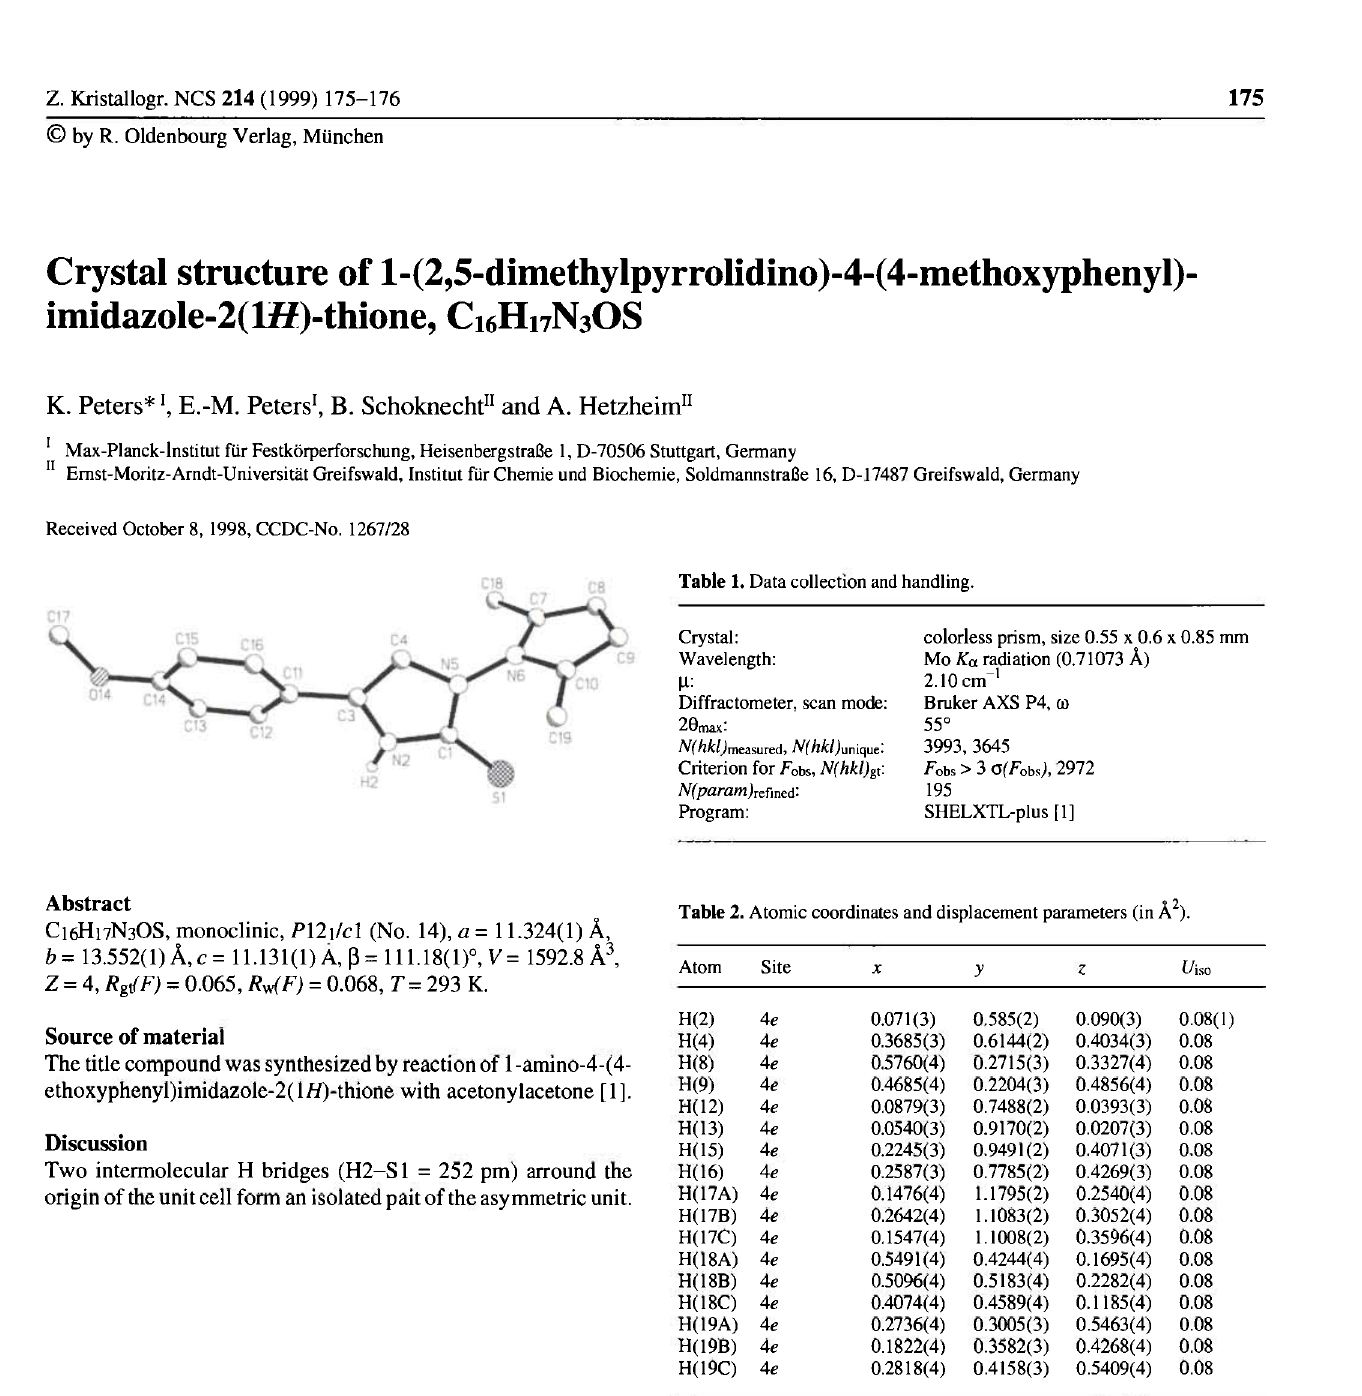
Table 3. Atomic coordinates and displacement parameters (in A 2